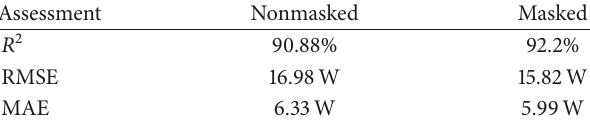
Table 4: Error values for nonmasked versus masked ANN.